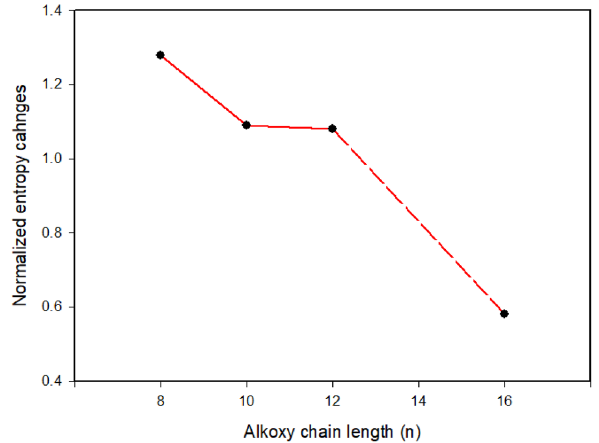
Figure 6. Dependence of entropy changes on the terminal alkoxy chain length